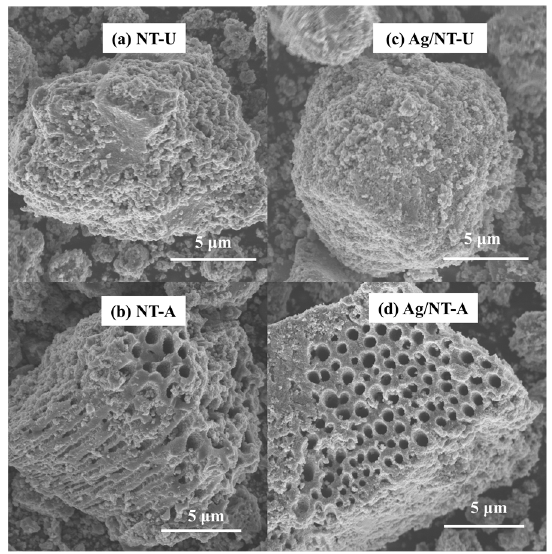
Figure 4. SEM morphologies of ( a ) NT-U, ( b ) NT-A, ( c ) Ag/NT-U, and ( d ) Ag/NT-A.